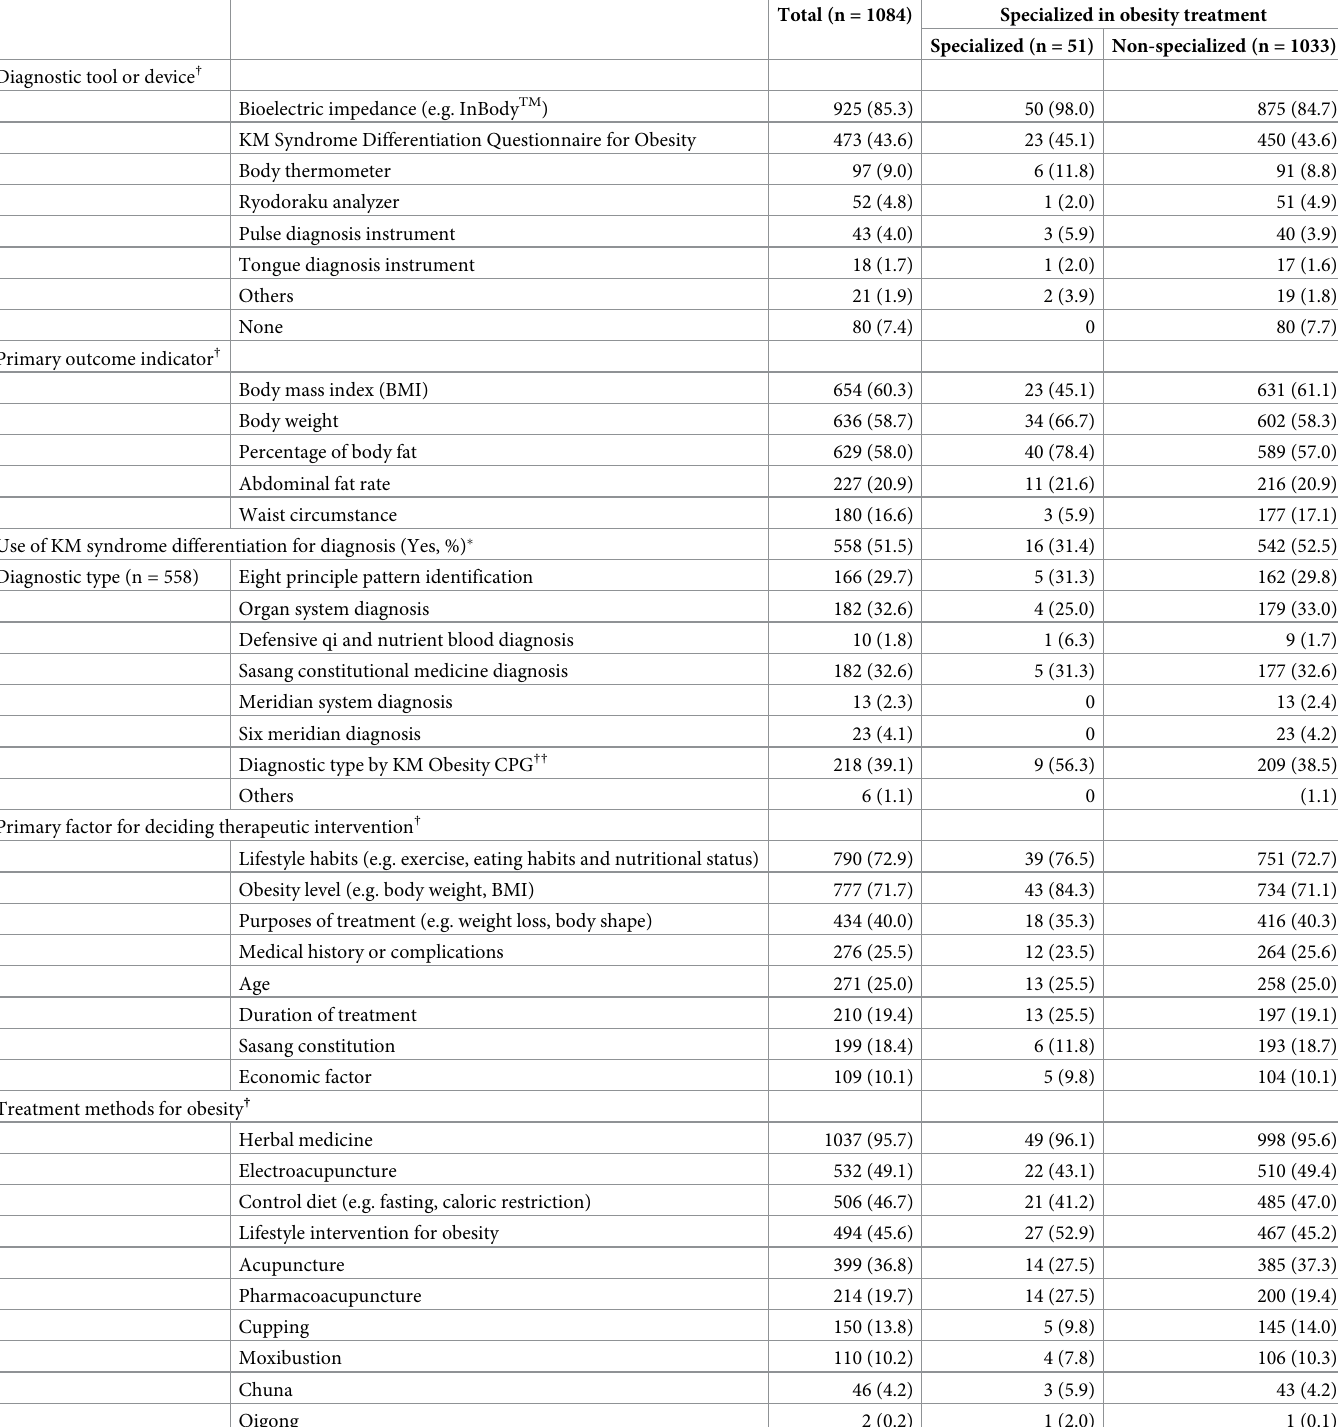
Table 3. Diagnostic tools and therapeutic intervention in KM for obesity